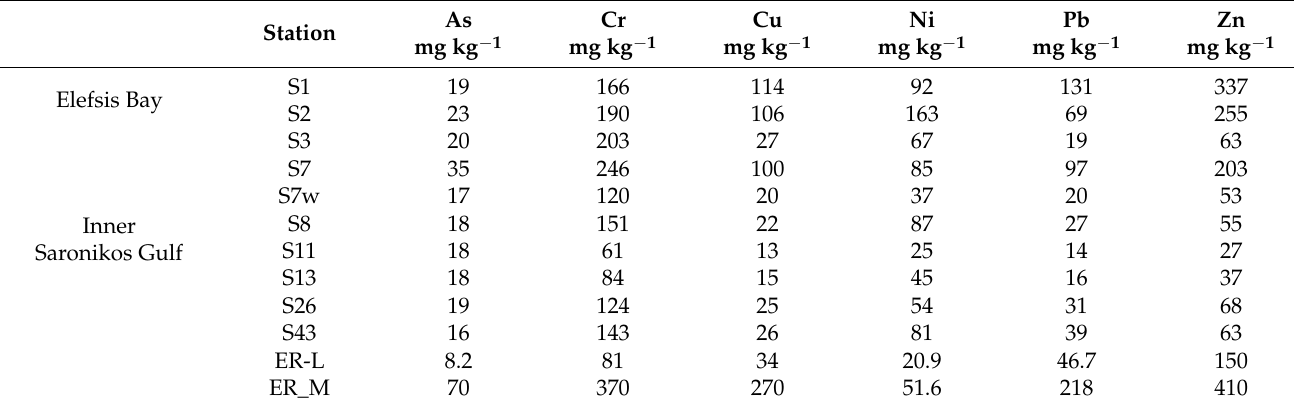
Table 2. Metal concentrations in the surface sediments.